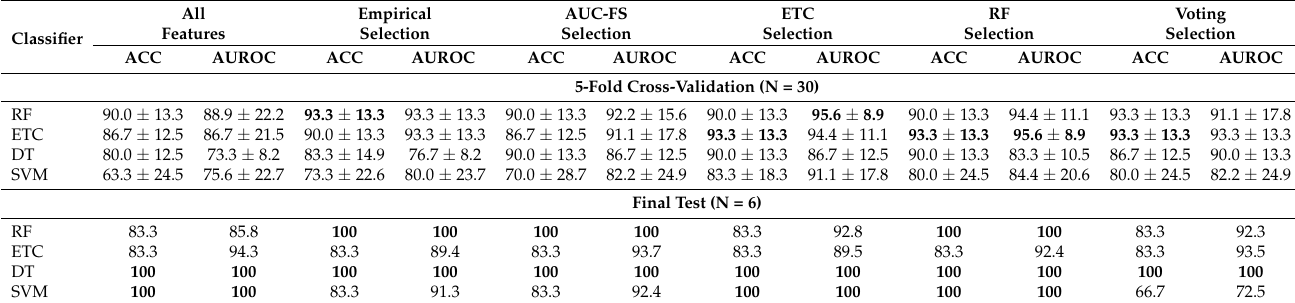
Table 3. Multimodal classification performance (%) between control vs. acute infection groups. Cross-validation results are expressed as mean and standard deviation. The best performances are presented in bold.